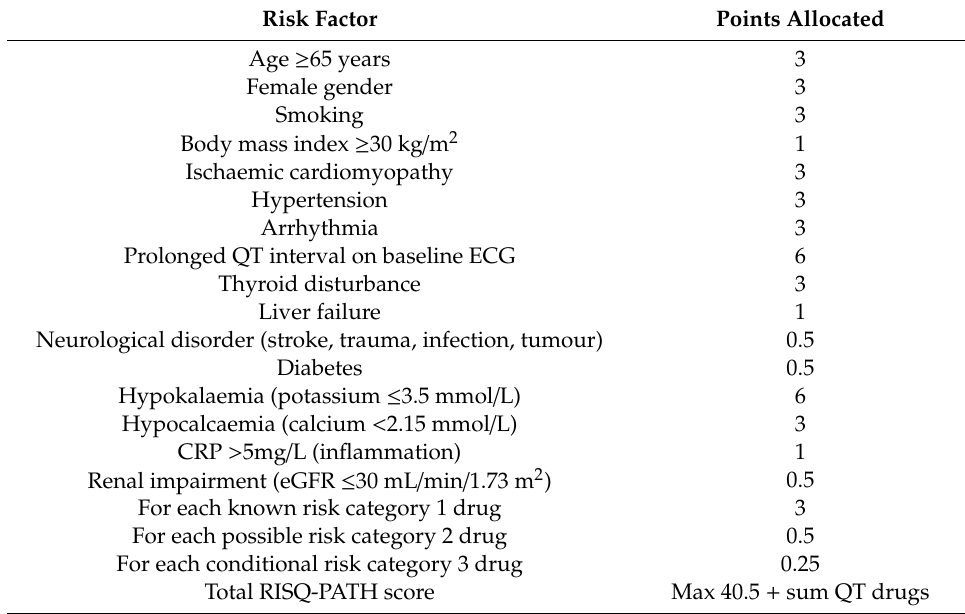
Table 1. Risk factors for QT prolongation according to RISQ-PATH score